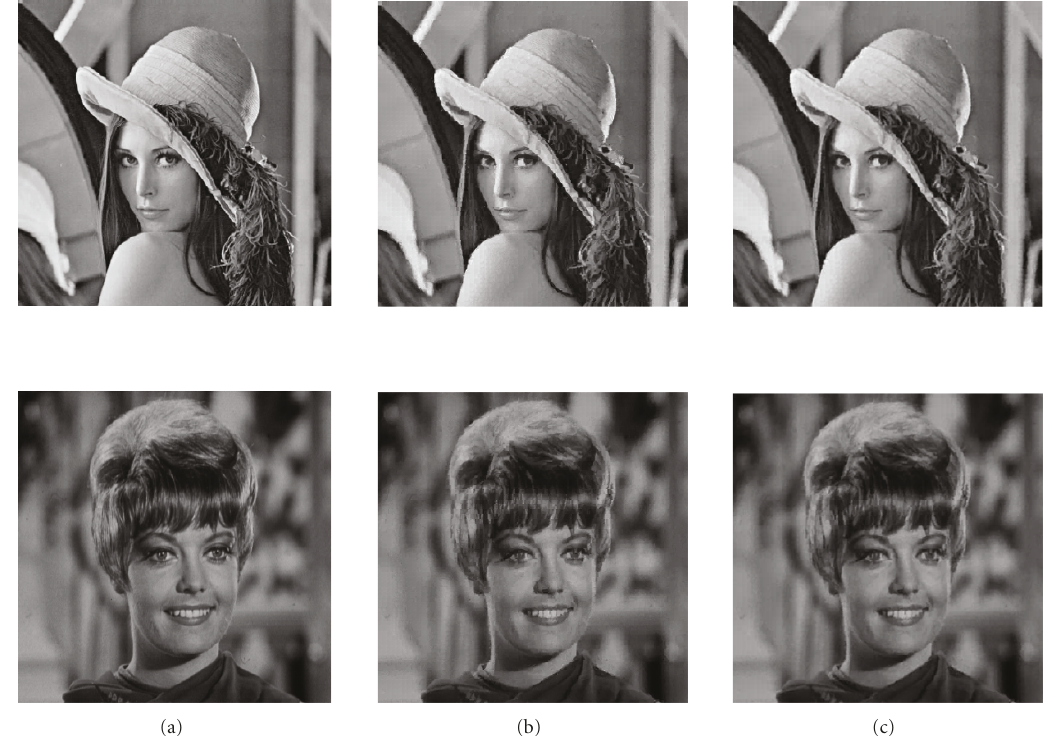
Figure 11: (a) Original, (b) reconstructed, and (c) filtered versions of the images (Lenna and F73) for the 1st group of experiments (Fold 1). Lenna: PSNR = 28,93 and 29,66 (filtered), F73: PSNR = 33,36 and 34,11 (filtered) (CR = 21,33).